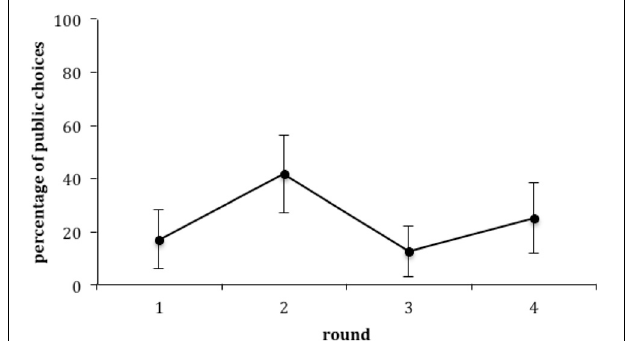
FIGURE 2 | Percentage of choices of public outcome for the four rounds of the game (mean ± 95% CI).